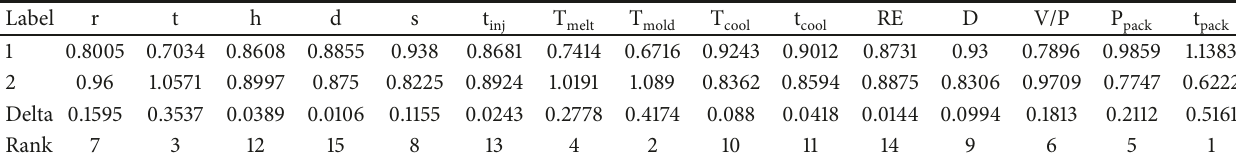
Table 5: Results of mean-value analysis.